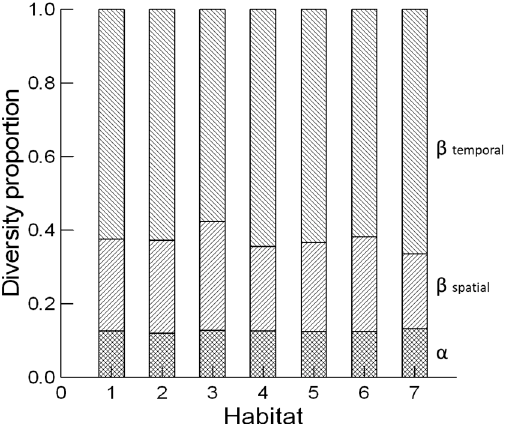
Figure 7. Stacked bar diagram showing the proportion of total ( γ ) partitioned to α , β spatial, β temporal diversity. The lower part of each column corresponds to the mean bimonthly α diversity.